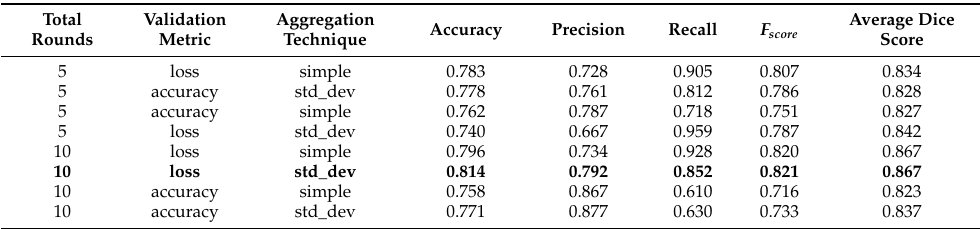
Table 3. Results of server-centric federated semi-supervised transfer learning experiments with an initial model obtained through training 10 epochs. The best performance is highlighted in bold.